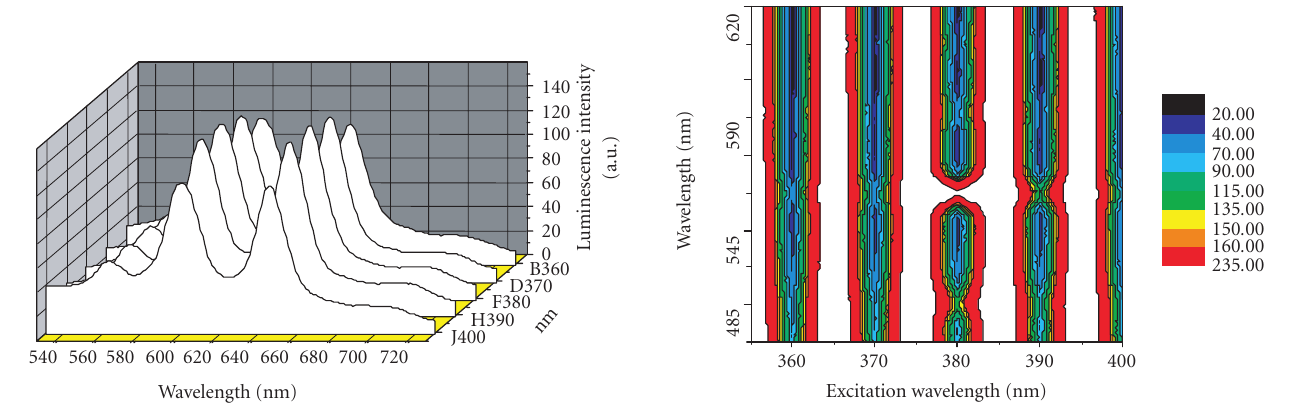
Figure 10: 3D view of the emission spectra of Sm 3+ ion in MC-Sm complex at di ff erent excitation wavelengths in DMSO.